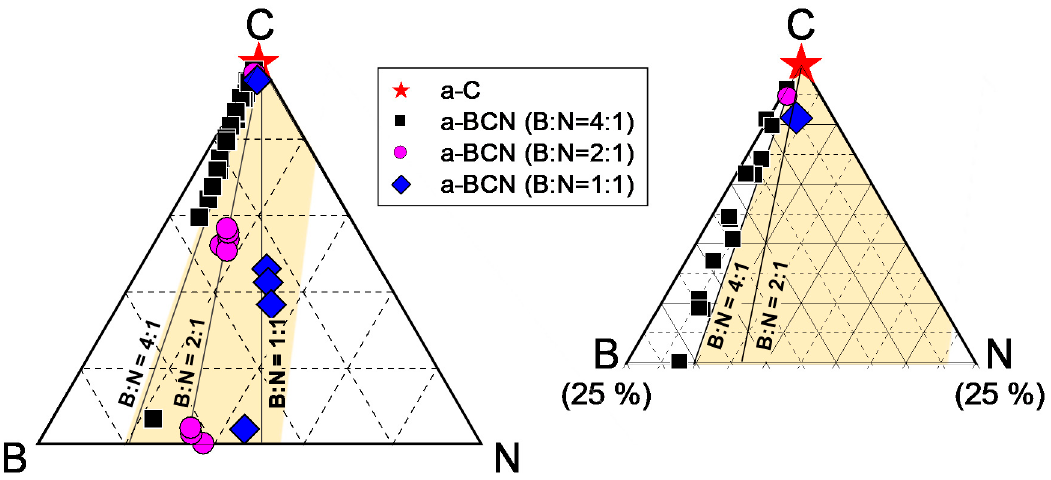
Figure 4. B–C–N ternary diagram showing the elemental composition of the a-BCN film.